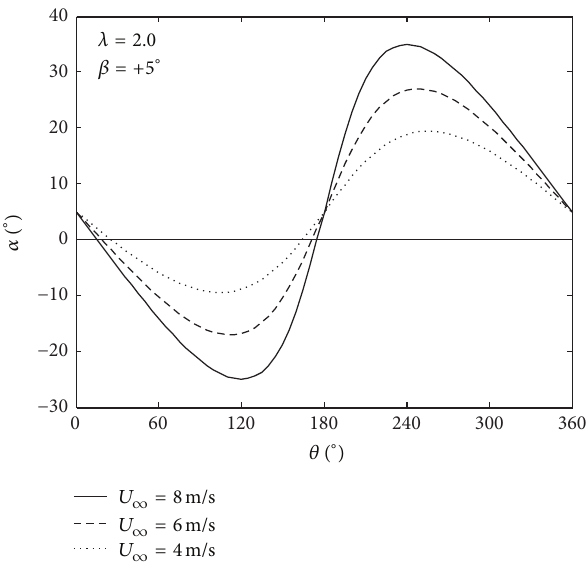
Figure 4: Incidence angle during a turbine revolution for different wind velocities, with fixed tip speed ratio and 5 ∘ positive blade pitch (curves shift upwards).